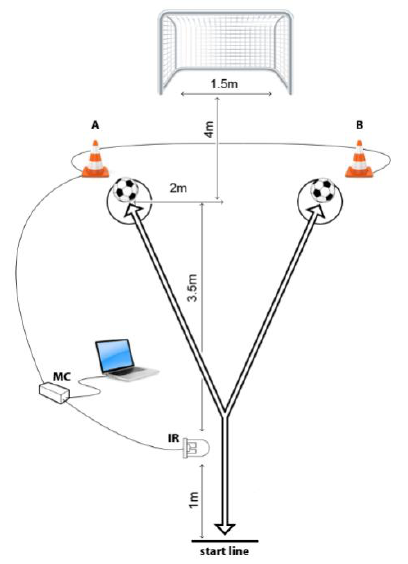
Figure 1. Football/specific reactive agility and change of direction testing polygon. Figure 1. Football / specific reactive agility and change of direction testing